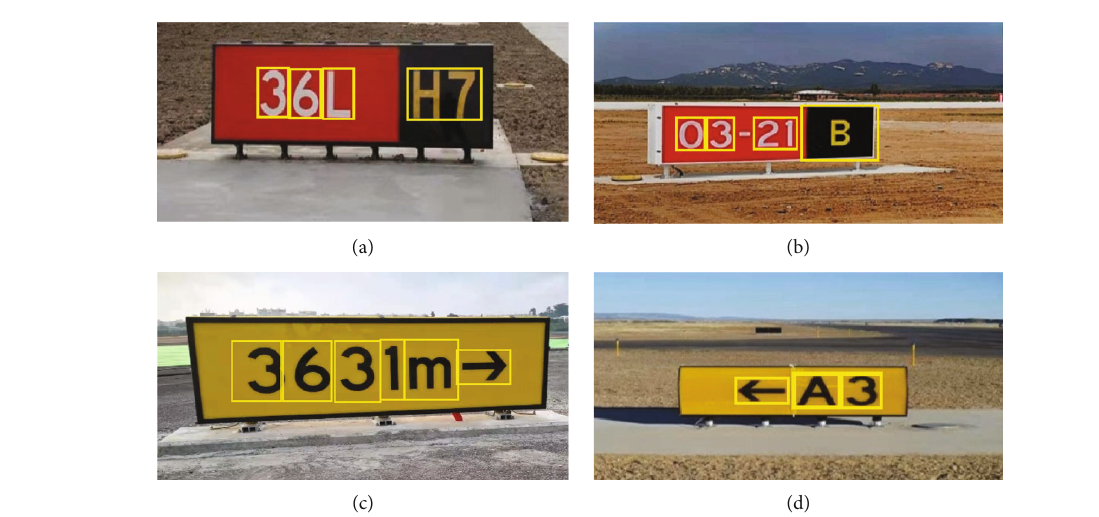
Figure 8: High-precision segmentation based on MSER and NMS.